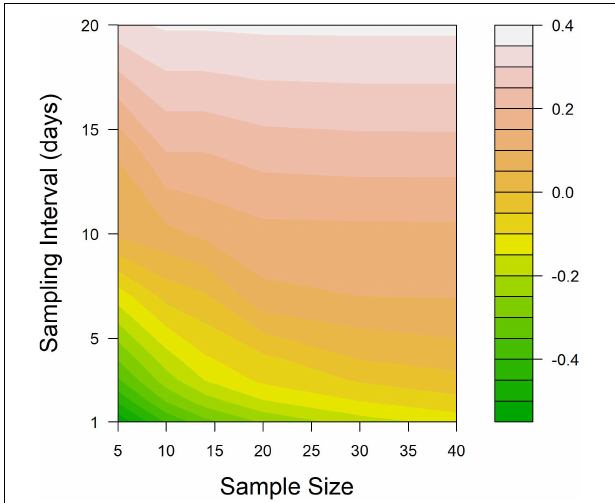
FIGURE 7 | Contour plot illustrating the impact of various sample sizes and sampling interval combinations on the suitability of treatment application. The suitability was assessed as the median value of True abundance – Treatment threshold at the time of all treatment, based on 5,000 simulations. The treatment threshold for these simulations was fixed at one adult female salmon